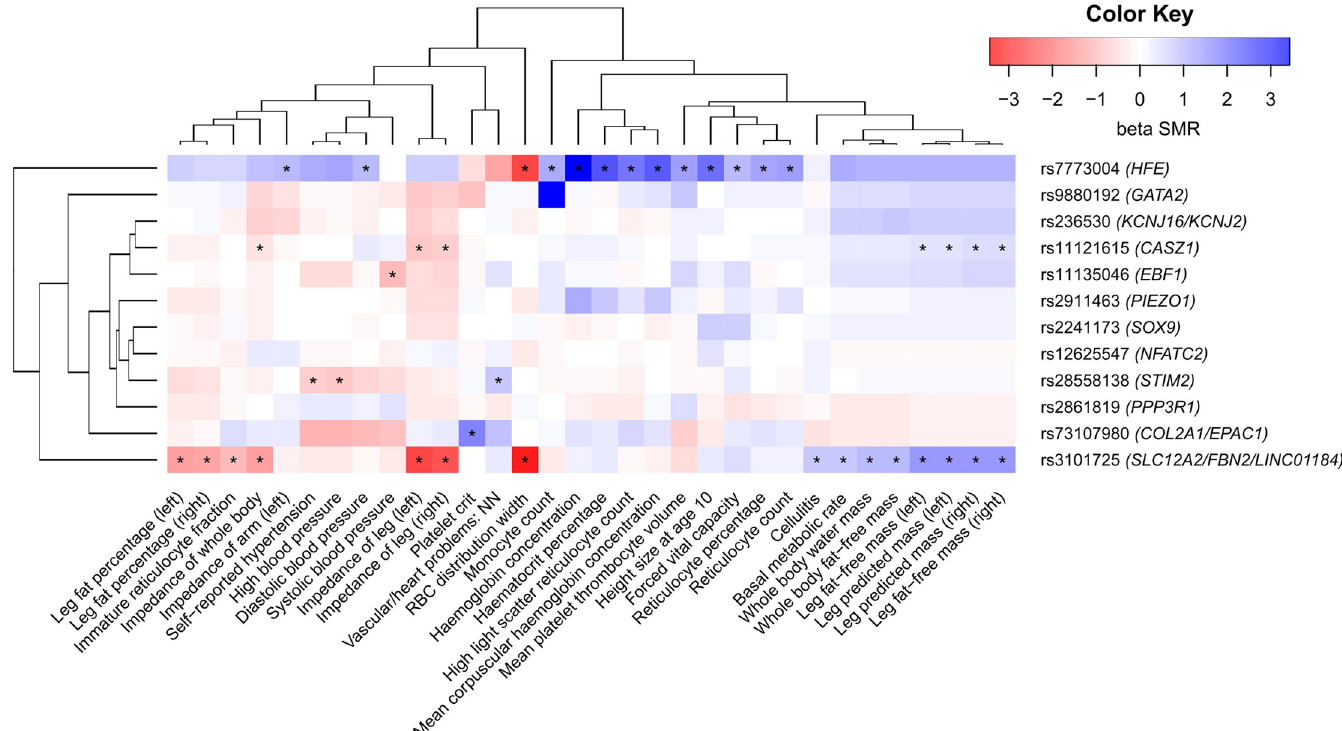
Fig 3. Pleiotropic effects of identified loci on other complex traits. Color depicts the sign and the magnitude of SMR beta coefficient. Negative sign (red) means opposed effects, and positive sign (blue) means the same direction of effect. Traits that passed both SMR and HEIDI test are marked with an asterisk. Prioritized genes in loci are shown in parentheses. Full names of traits as indicated in the Neale lab and the Gene ATLAS databases are given in S11 Table. RBC, red blood cell.